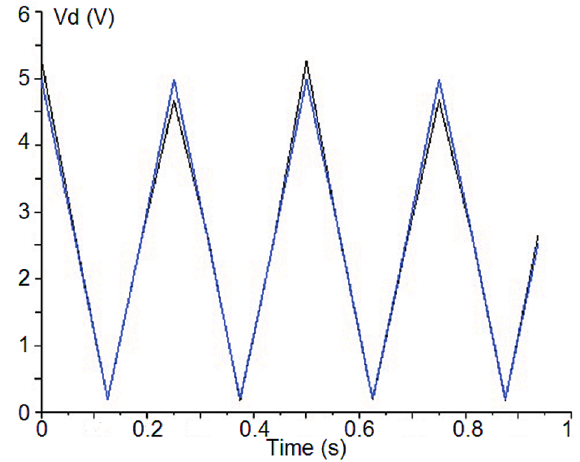
Figure 3. Detected voltage waveform from Table 2 values (black trace) and the resulting waveform calculated from the FFT of the measured values (blue trace).